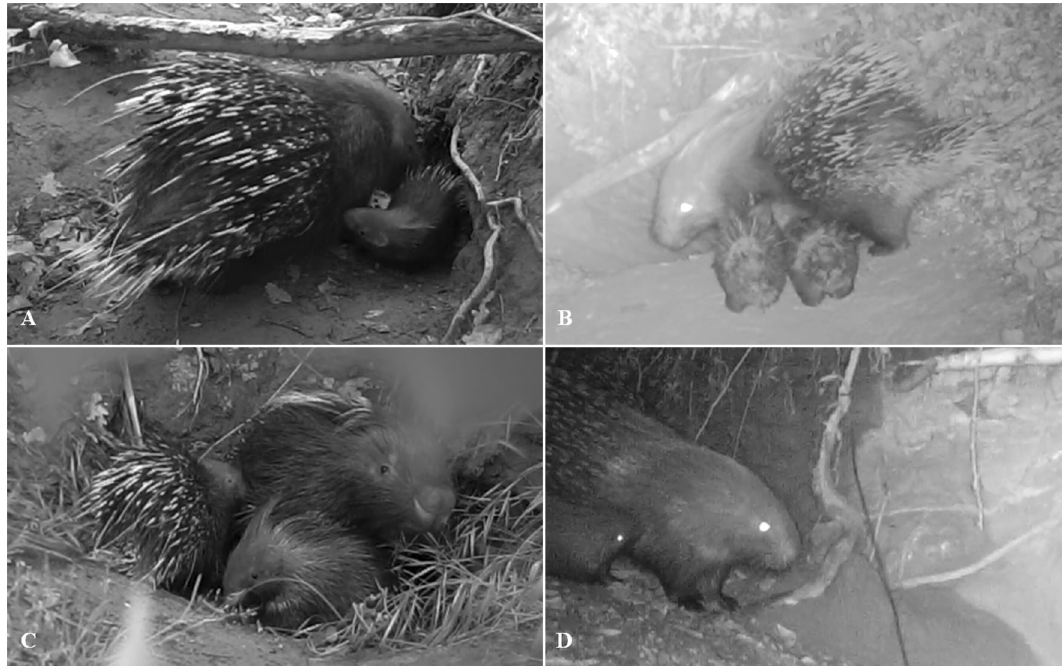
Figure 6. Adult female of Pair 4 ( A ), of Pair 1 ( B ), of Pair 2 ( C ) and of Pair 3 ( D ) while nursing porcupettes.